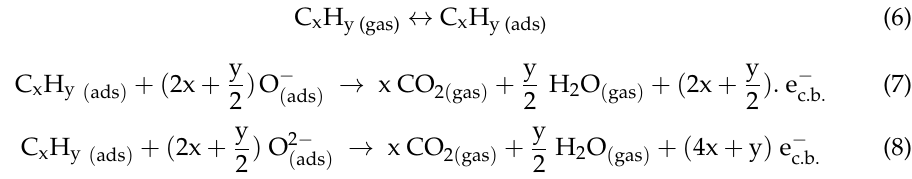
Table 2. A comparison of MOS-based gas sensor arrays for the detection of BTEX in air.